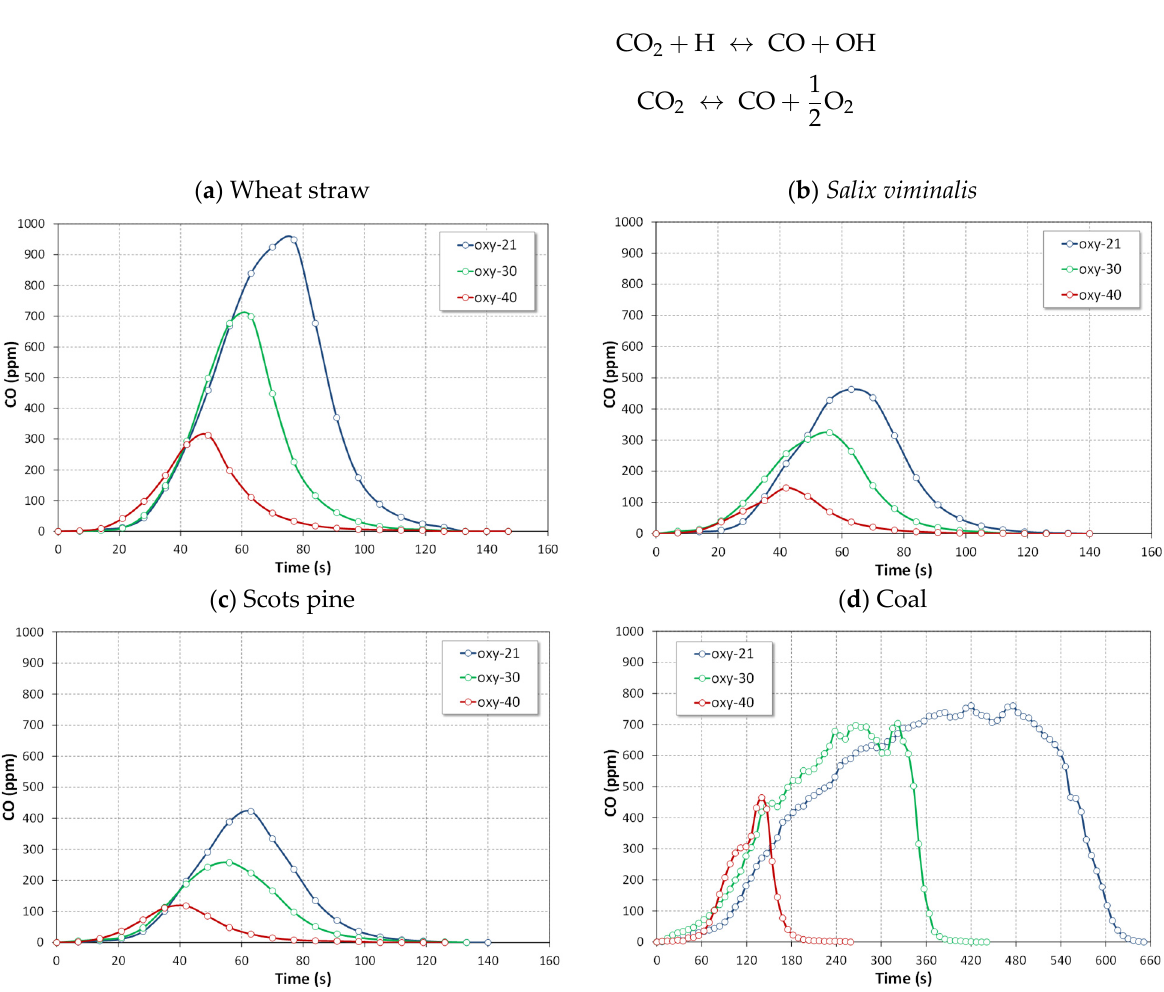
Figure 17. Effect of oxygen concentration on the instantaneous CO concentrations during oxy- combustion.